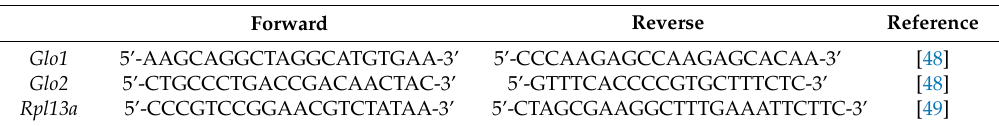
Table 2. Primer sequences used for amplicon